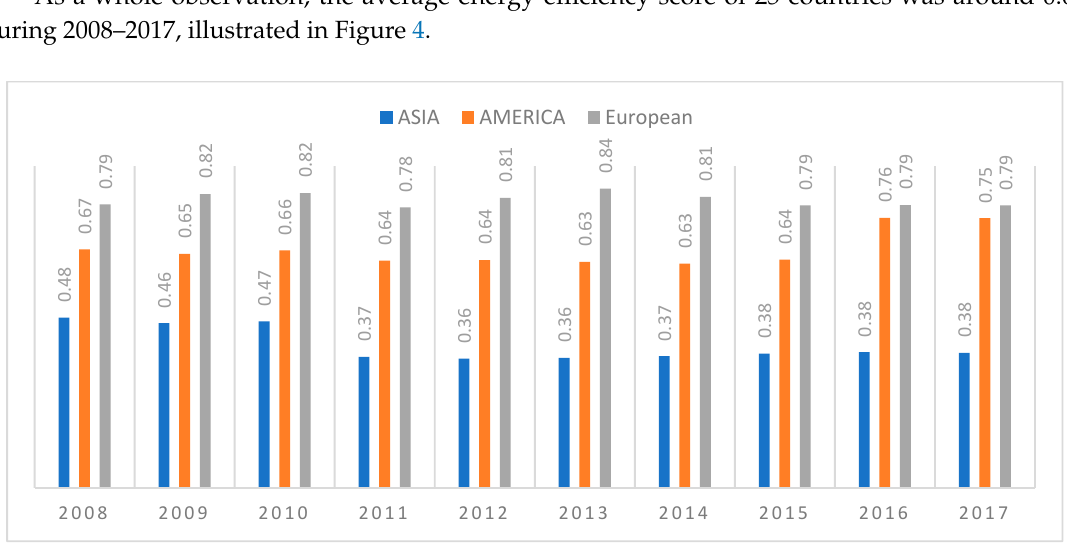
Figure 3. Energy e ffi ciency of Europe, the Americas, and Asia from 2008 to 2017. Figure 3. Energy efficiency of Europe, the Americas, and Asia from 2008 to 2017.